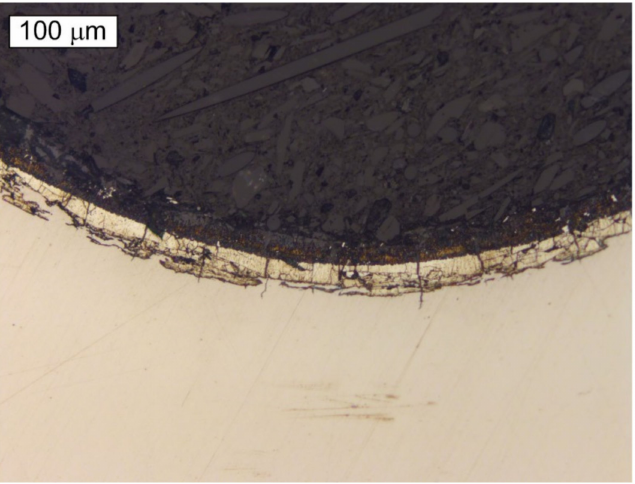
Figure 12. Microscopic image of a longitudinal section of the S2 bolt. Visible cracks initiating in the thread root. Non-etched state, Light Microscopy.